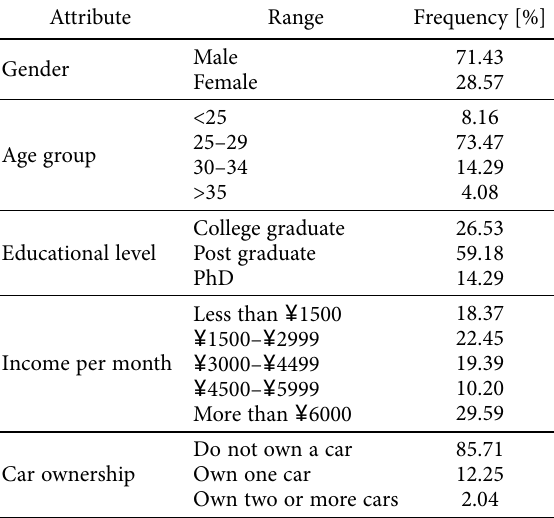
Table 5. Socioeconomic characteristics of survey